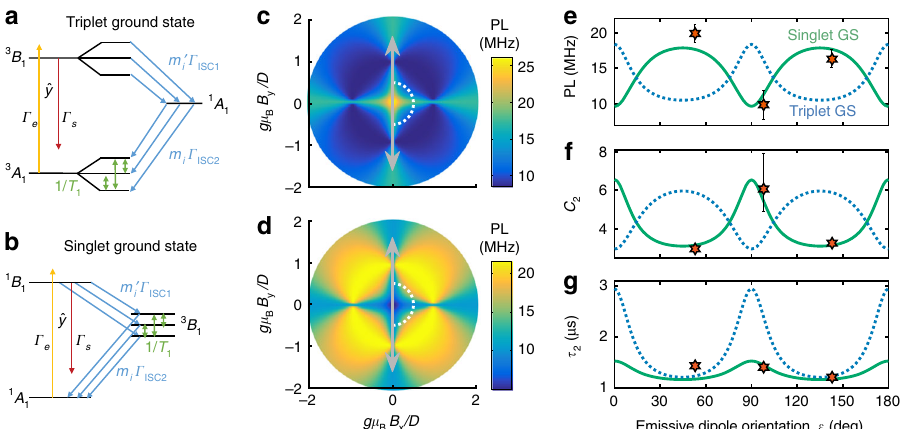
Fig. 4 Inter-system crossing models. a , b Energy-level diagrams showing the symmetry-allowed transitions for a triplet-singlet ISC ( a ) and a singlet-triplet ISC ( b ). c , d Steady-state PL simulations for level diagrams in a and b , respectively, as a function of in-plane magnetic fi eld ( β = 0°). e , f Simulated PL amplitude ( e ), bunching amplitude ( f ), and bunching time ( g ) as a function of fi eld orientation, ε , shown as dashed blue and solid green curves for calculations along the dashed curves in c and d , respectively [ g μ B B / D = 0.5]. Star symbols indicate background-corrected measurements. PL measurements in e are multiplied by 1000, and error bars are derived from steady-state PL measurements at comparable fi eld values from Fig. 3c. Error bars in e represent uncertainty in spatial Gaussian fi ts to PL images and steady-state variations for fi eld-dependent measurements. Error bars in f and g represent 68% con fi dence intervals from fi ts to raw autocorrelation data, propagated to corresponding background-corrected values including uncertainty in the signal and